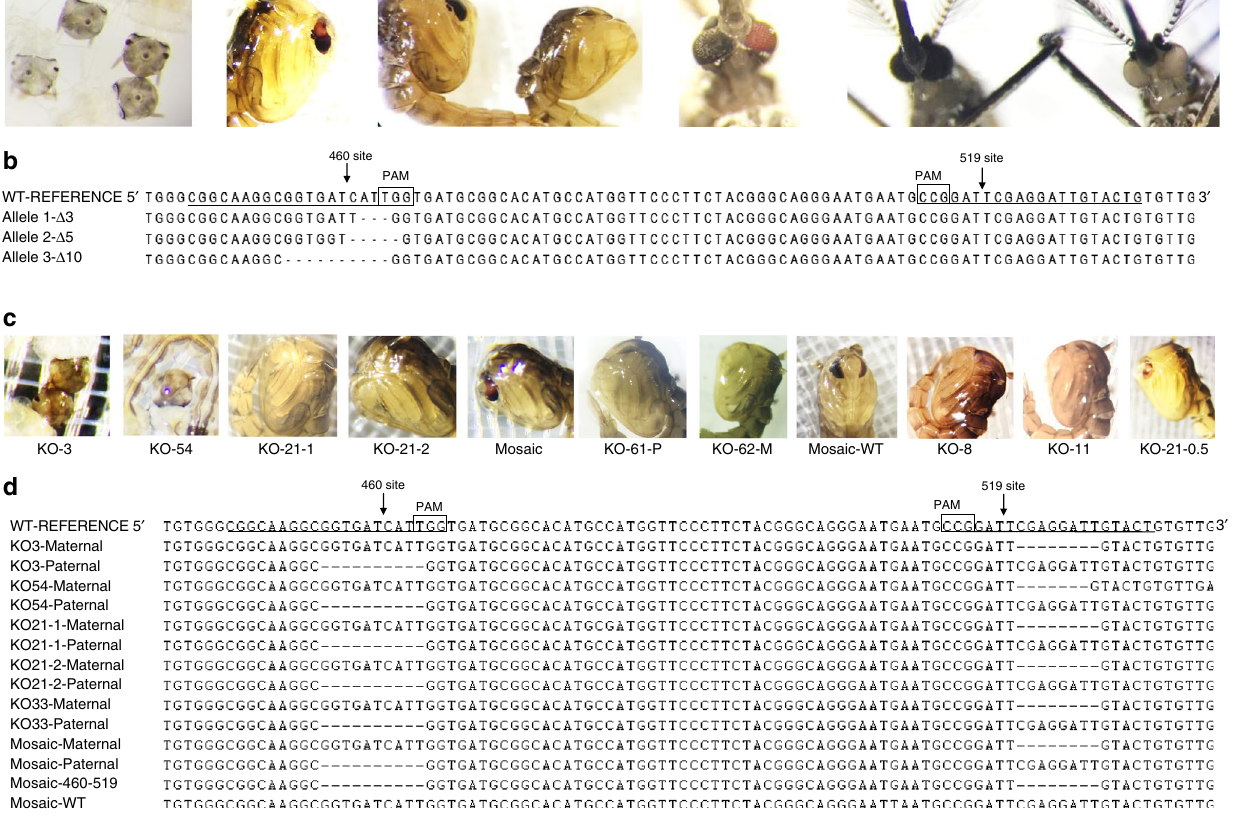
Fig. 3 Cas9-mediated gene editing in A. aegypti by embryo injection and ReMOT Control. a Example phenotypes of individuals obtained after standard embryonic microinjection into A. aegypti embryos of Cas9, P2C-Cas9, and P2C-EGFP-Cas9 fusion RNP complexed with sgRNA460. From left to right: G 0 white and wild-type larvae; mosaic pupae; wild-type and white pupae; mosaic adult; wild-type and white adults. b Genotypes of alleles obtained at the 460 site from selected recovered white-eye offspring. The allele 3 Δ -10 was isolated in a colony of white-eye mosquitoes (Wh-iso8-kmo 460 ). c Phenotypes of offspring obtained after female injection of ReMOT Control RNPs complexed with sgRNA519* into A. aegypti females. d Genotypes of obtained modi fi ed offspring. Note the maternal and paternal allele clone sequences of knockout individuals. Mosaic individuals showed both mutated sites and intact WT sequences in clones from the same